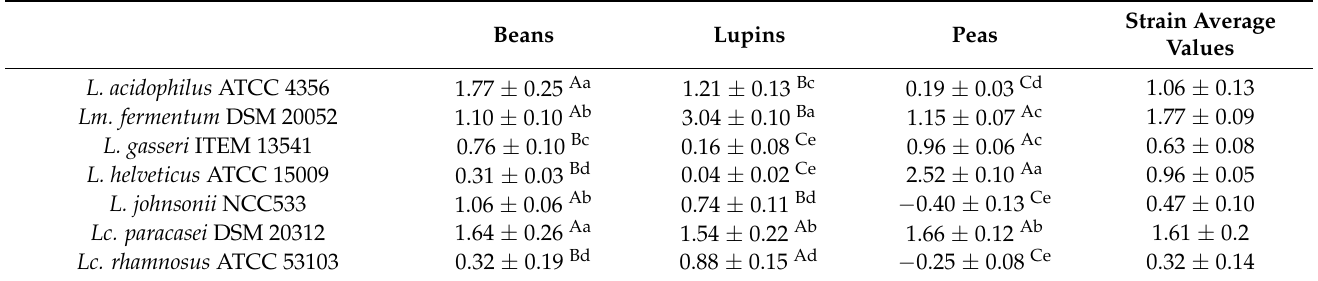
Table 2. Differences in cell densities, reported as ∆ log cfu mL − 1 , after 48 h of incubation at 37 ◦ C, for legume grain water extracts inoculated with selected LAB strains.